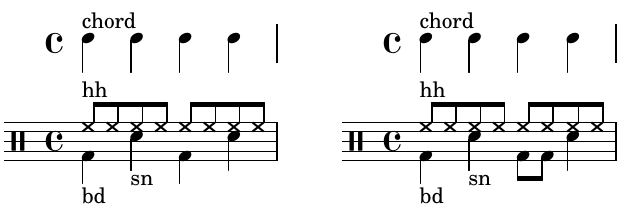
Figure 4. Chord and drum patterns for artificial datasets 1–3 ( left ), and 4 ( right